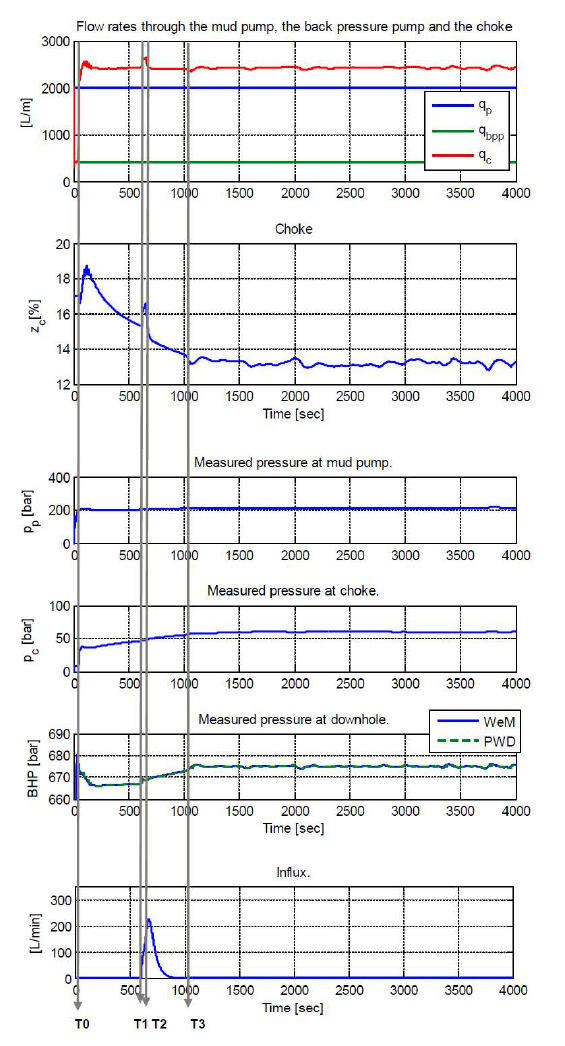
Figure 5: Case 3: Flowrates, choke opening, measured pressure and Influx flow rate using DSI on Well 2.